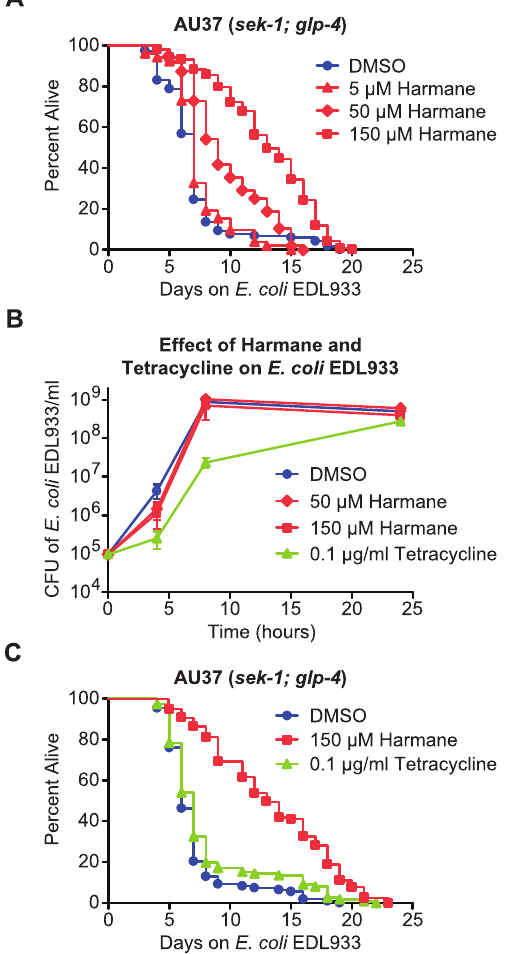
Figure 1. The effect of Harmane is dose-dependent, but unrelated to its antimicrobial effect. (A) E. coli EDL933 infection assay on sek-1 ; glp-4 nematodes with different concentrations of Harmane compared to the solvent (DMSO). The lifespan extension is significant for the two highest concentrations of Harmane compared to DMSO ( P , 0.0001) [DMSO, n=118; 5 m M, n=52; 50 m M, n=48; 150 m M, n=119]. (B) Growth assay on E. coli EDL933 in NGM medium with different concentrations of Harmane or the solvent (DMSO), compared to E. coli EDL933 grown in NGM medium with 0.1 m g/ml of the antibiotic tetracycline. Both concentrations of Harmane affect the growth of EDL933, but not as much as 0.1 m g/ml of tetracycline. Data points are the average of three replicates and error bars represent SEM. (C) E. coli EDL933 infection assay on sek-1 ; glp-4 nematodes with comparable concentrations of Harmane and tetracycline, compared to DMSO. Tetracycline, at 0.1 m g/ml, extends the lifespan significantly ( P =0.0283) as well does 150 m M Harmane ( P , 0.0001). However, the mean survival of nematodes on DMSO is 6 days, compared to 7 days for 0.1 m g/ml tetracycline and 13 days for 150 m M Harmane [DMSO, n=108; 0.1 m g/ml Tetracycline, n=111; 150 m M Harmane n=117].